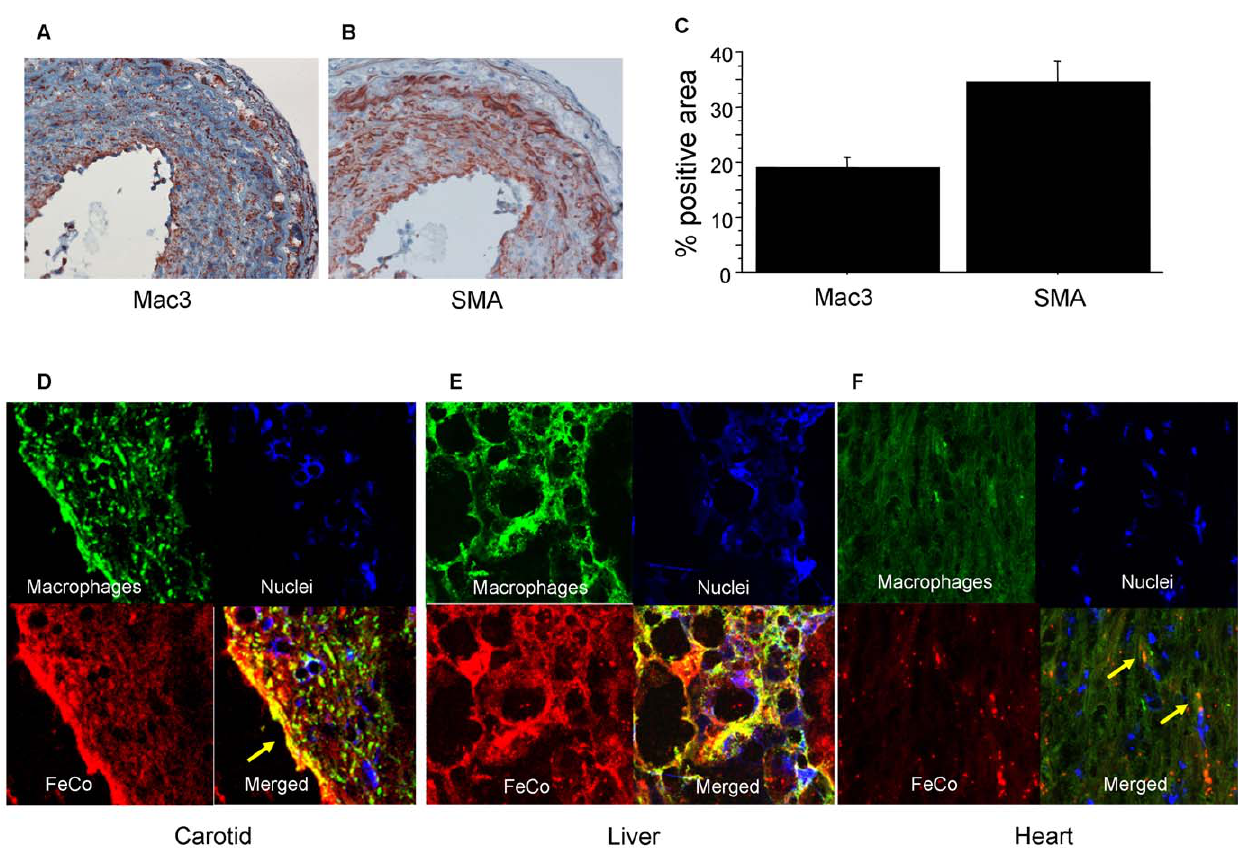
Figure 3. Immunostaining of macrophages and FeCo/GC. ( A ) Immunohistochemical staining showed macrophages (by anti-Mac3 antibody) infiltrating the neointima of the ligated left carotid artery. ( B ) Immunohistochemical staining for smooth muscle cells (by anti-SMA antibody). ( C ) Quantitative analysis of proportion of neointima composed of macrophages and smooth muscle cells. ( D ) Immunofluorescent staining demonstrated macrophages (green), FeCo/GC-Cy5.5 (red), nuclei (blue), and combined staining with strong colocalization (yellow), particularly near the luminal border (arrow). ( E ) Immunofluorescent staining of the macrophage-rich liver also demonstrated strong colocalization (yellow) of FeCo/GC and macrophages. (F) By contrast, the macrophage-poor heart tissue showed scant FeCo/GC uptake, with the few spots of uptake colocalizing with macrophages (arrows).